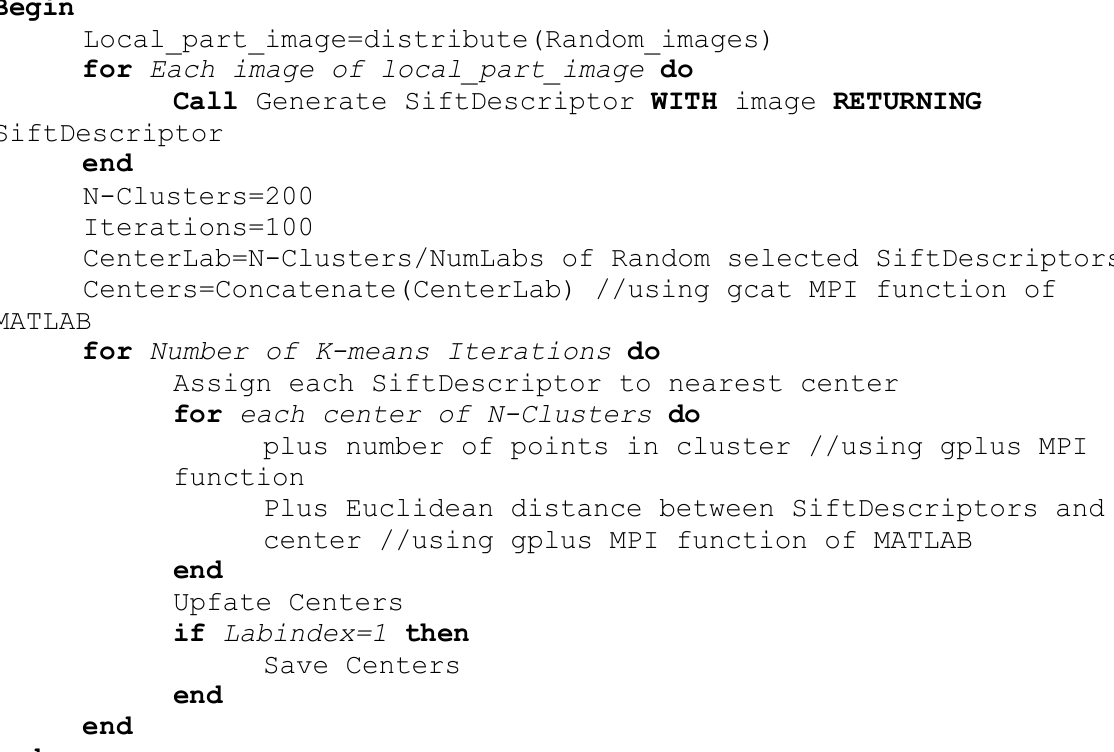
Figure 4. Pseudo-code of Job 1 that runs on workers simultaneously. Some functions not interfering with parallel implementation are considered as black box and are just